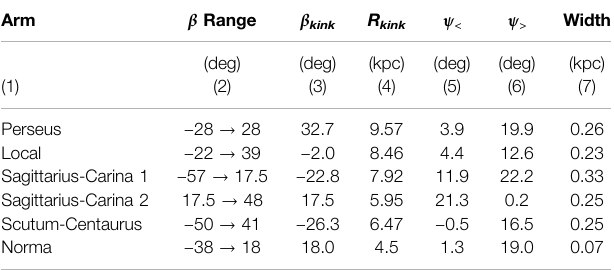
which is de fi ned as 0 ◦ toward the Sun and increases in the Galactic rotation direction. β